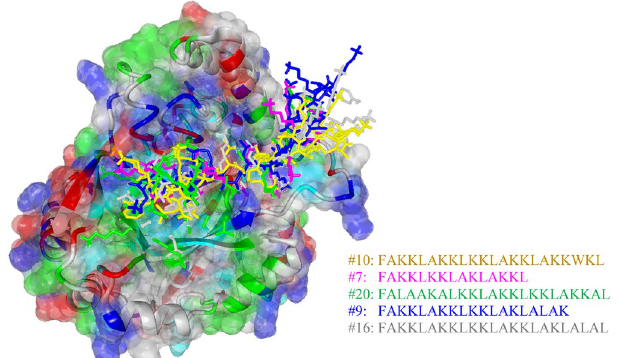
Figure 4. Three-dimensional complex structure of the top 5 ACPs having maximum interaction energies . The binding pocket was colored according to residue type by YASARA coloring scheme, where grey, green, blue, red and cyan colors represent non-polar, amidic, basic, acidic hydroxylic amino acids,